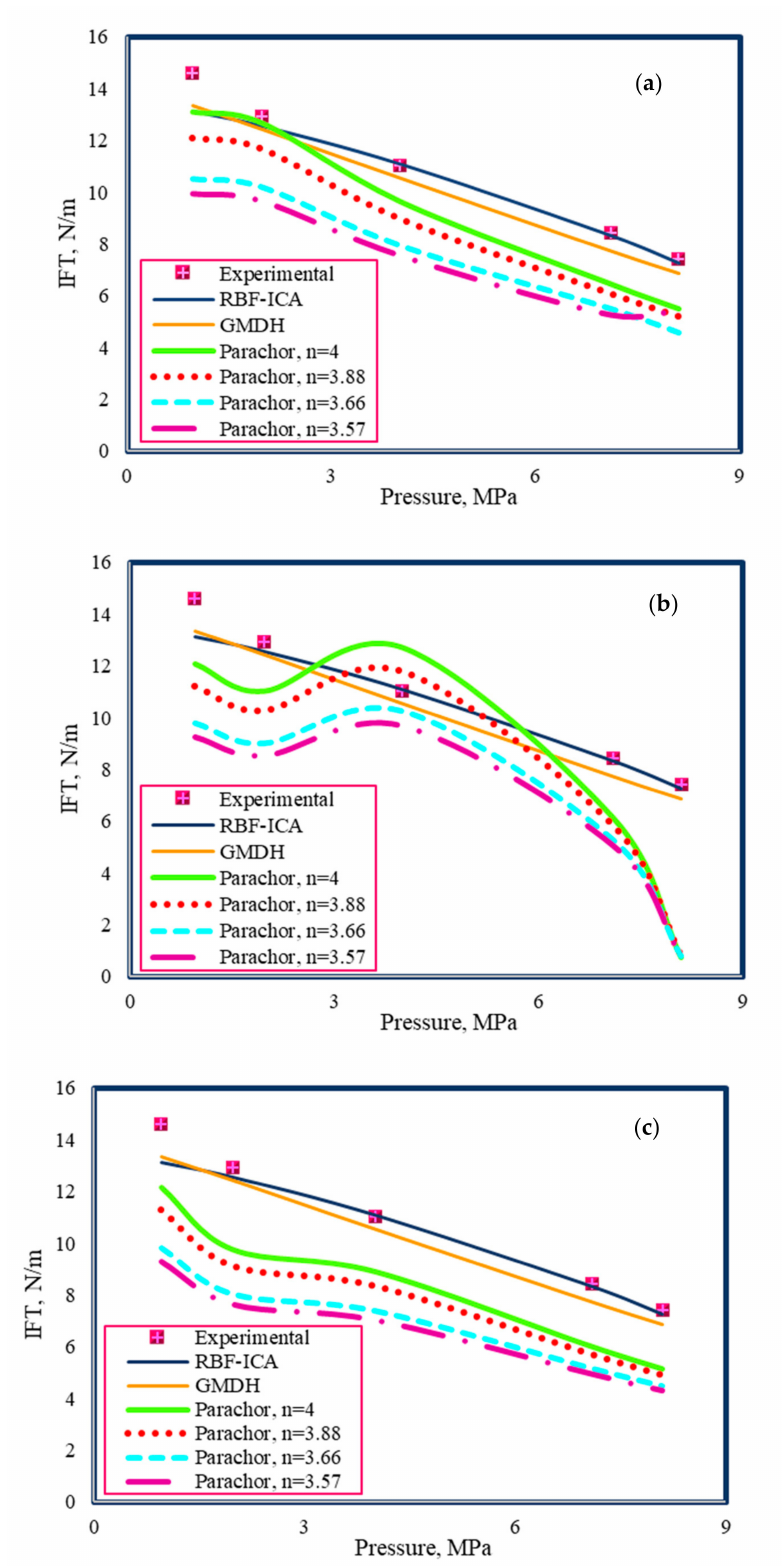
Figure 11. A comparison between the experimental and estimated IFT values of CO 2– n-decane systems using the Parachor equation with different values of n in combination with: ( a ) PR(3), ( b ) SRK(3), and ( c ) ZJ EOSs at different